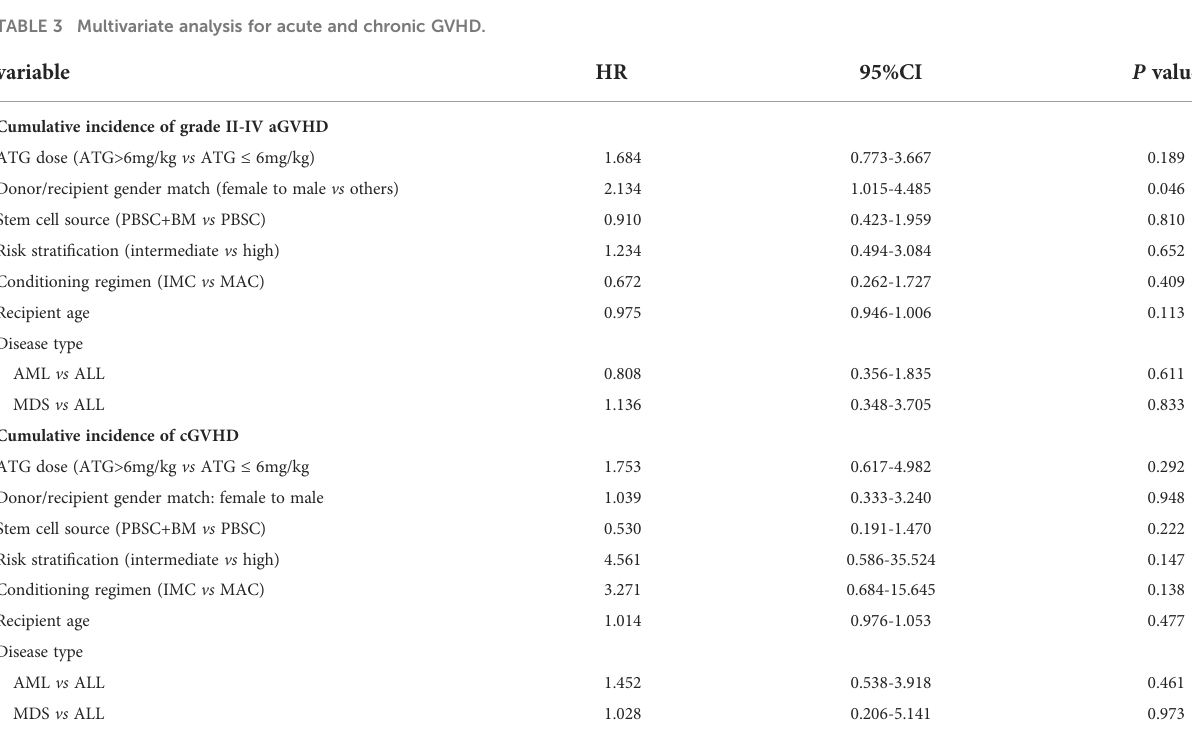
TABLE 3 Multivariate analysis for acute and chronic